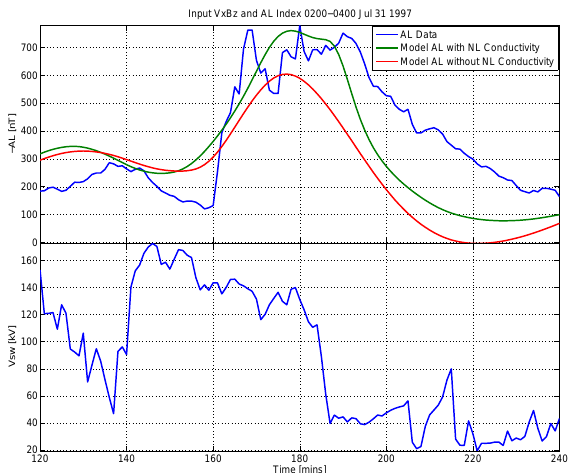
Fig. 4. 31 July 1997 substorm analysis with the WINDMI model. The result when using only a reconnection trigger (ARV = 1.06) is compared to the result when conductivity enhancement (ARV = Fig. 4. July 31 1997 substorm analysis with the WINDMI model. 0.55) is also